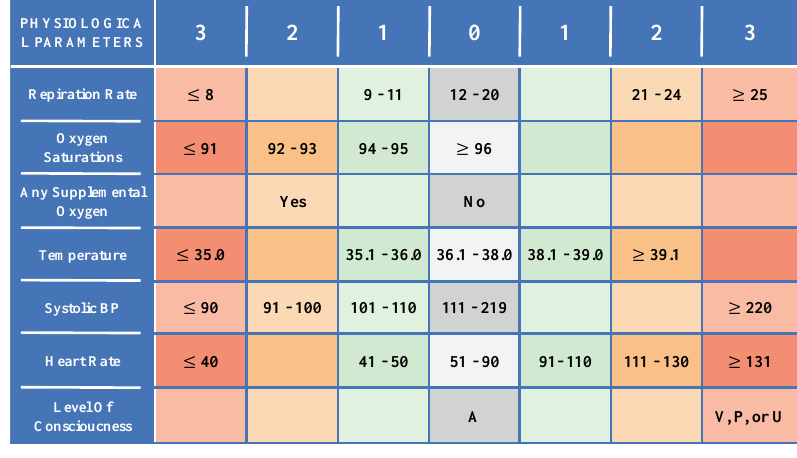
Figure 2. National Early Warning Score (NEWS) [30].